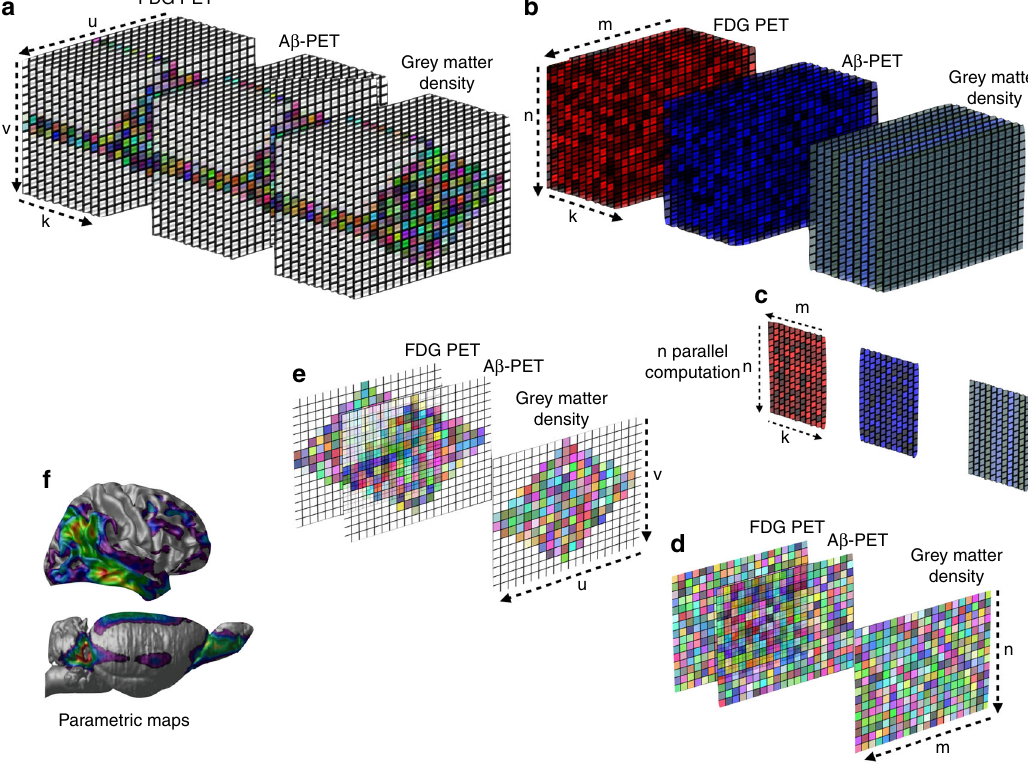
Fig. 9 Multimodal analytical operations performed at every brain voxel. The illustration shows the analytical model developed to perform statistical operations on multiple scalar variables and with multiple imaging modalities at every brain voxel in humans and rats. Brie fl y, ( a ) the brain image data were retrieved from a 3D image space and converted to a 2D matrix in the image space for each subject. b Then, the image data were transformed into the processing space using arti fi cial parcellation. c In the computational phase, the statistical modeling was performed in every brain voxel accounting for voxel and global PET uptake values, as well as voxel gray matter density and covariates. d Subsequently, statistical matrices were generated from the results and ( e ) transformed back to the 3D image space. f Finally, 3D parametric maps displaying the results of the regression models were generated. k = subjects, u = image slice, v = slice elements, m = arti fi cial parcellation, n = elements in each